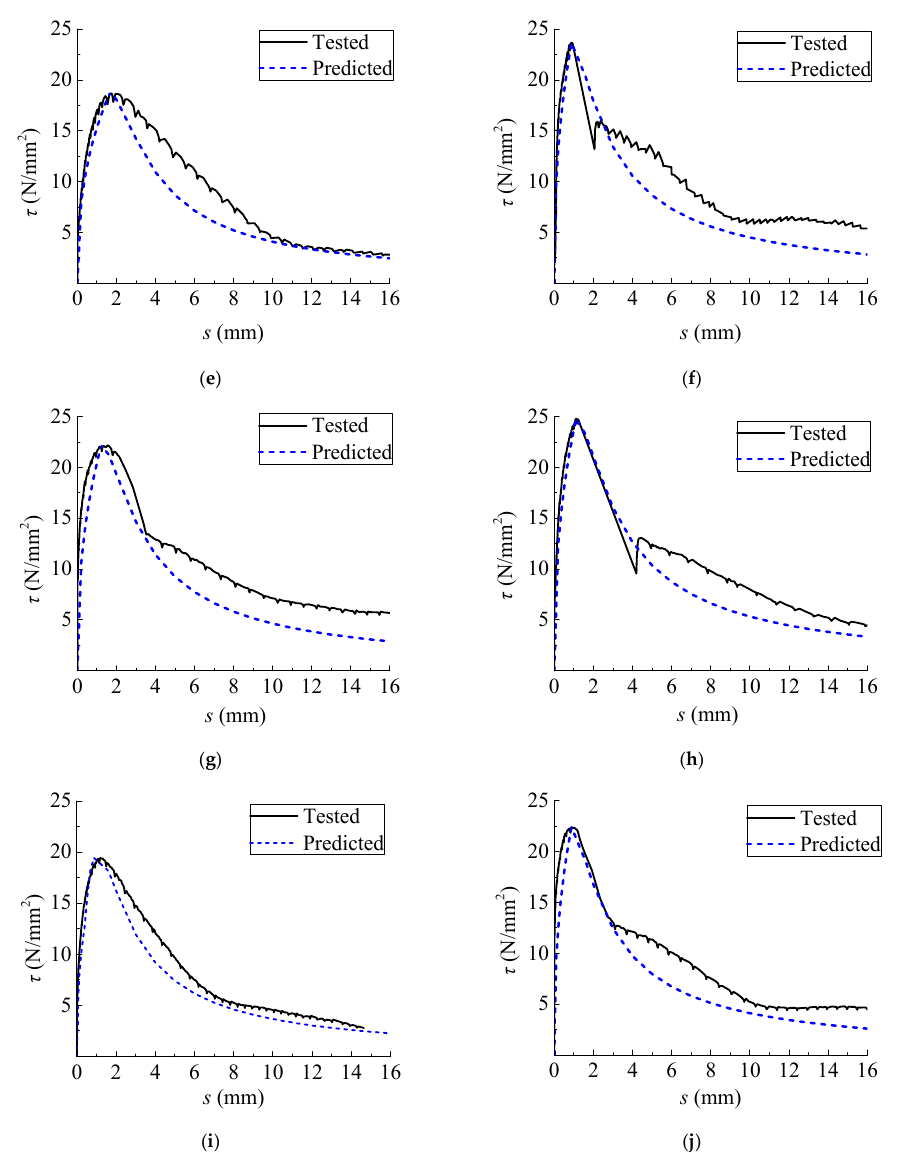
Figure 14. Comparisons between experimental and predicted bond–slip curves. (a) A28; (b) B28; (c) A90; (d) B90; (e) A180; (f) B180; (g) A270; (h) B270; (i) A360; (j) B360.